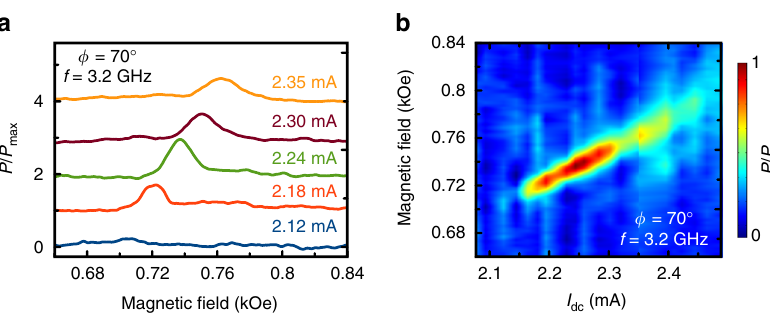
Fig. 2 YIG/Pt nanowire microwave signal generation. a Spectra of normalized microwave power P / P max generated by the nanowire at the frequency f = 3.2 GHz and magnetic fi eld angle ϕ = 70° as a function of magnetic fi eld at several direct current biases (vertically offset for clarity). b Color plot of microwave power generated by the nanowire at 3.2 GHz as a function of magnetic fi eld and direct current bias